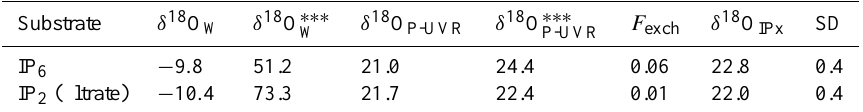
Table 1. Results from UVR digestion of organic P compounds. The table shows measured δ 18 O values of 18 O-labeled water ( δ 18 O ∗∗∗ non-labeled ( δ 18 O W ) water, as well as δ 18 O values of UVR-released phosphate in assays with 18 O-labeled water ( δ 18 O ∗∗∗ water ( δ 18 O IPx ). The δ 18 O S value was calculated according to Eq. (1). Exchanged F exch is the fraction of oxygen atoms which exchanged with water calculated with Eq. (2).